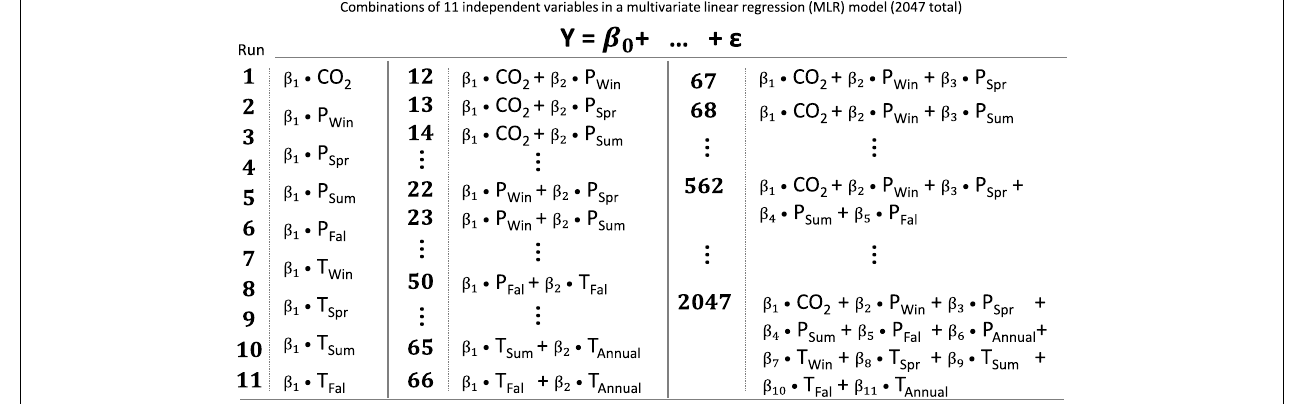
Frontiers in Environmental Science |